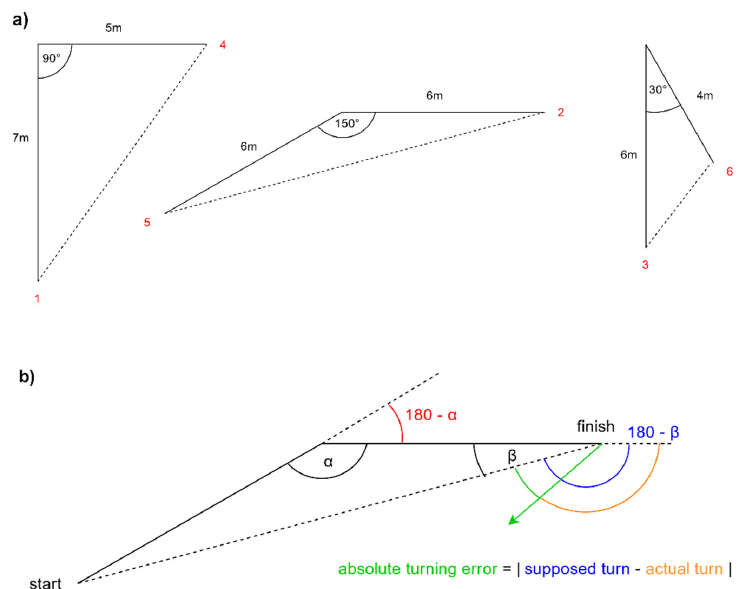
Figure 5. The participants were led along the sides of the three triangles with inner angles of 90 ◦ (right-angled triangle), 150 ◦ (isosceles triangle) and 30 ◦ in the order of the red numbers ( a ). The turns which the participants had to perform are depicted in ( b ). At the finishing point, the participants had to turn back to the starting point. The absolute difference between the actual turning angle and the instructed turning angle results in the absolute turning error ( b